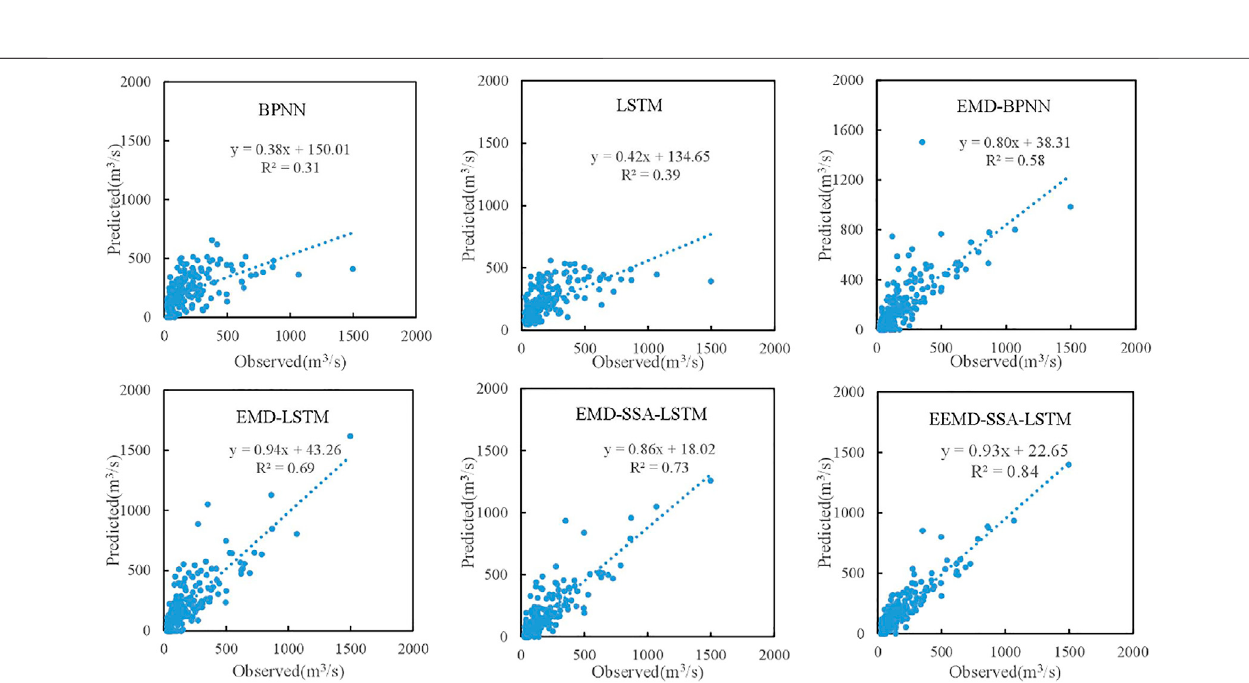
FIGURE 7 | Comparison of scatter diagrams of forecast results for the Xinfengjiang Reservoir during the validation period.